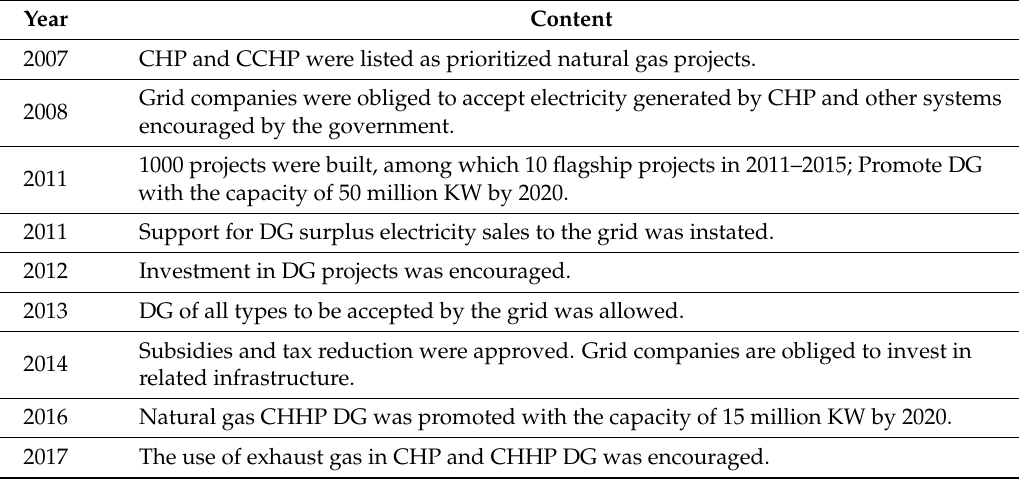
Table 1. Policies regarding natural gas distributed generation (DG) in China [6].